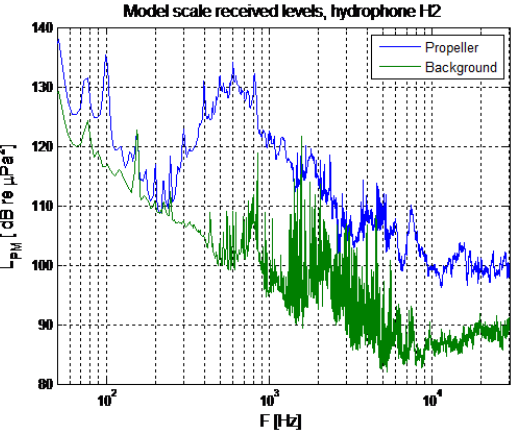
Figure 18: Cavitation tunnel received levels, hydrophone